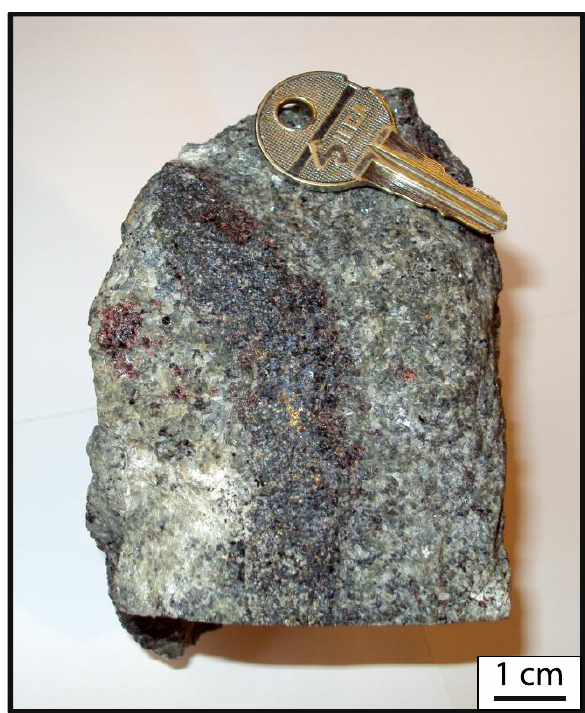
Figure 2. Photograph of rock sample 93-BD-35 containing the 2-cm wide nelsonite dike (dark, in center) cutting feldspar + garnet + biotite + quartz + sillimanite ± hercynite gneiss (greenish-gray). The small nelsonite dike contains microscopic sapphires. The dike may have experienced shearing during the Ottawan phase of the Grenville Orogeny.